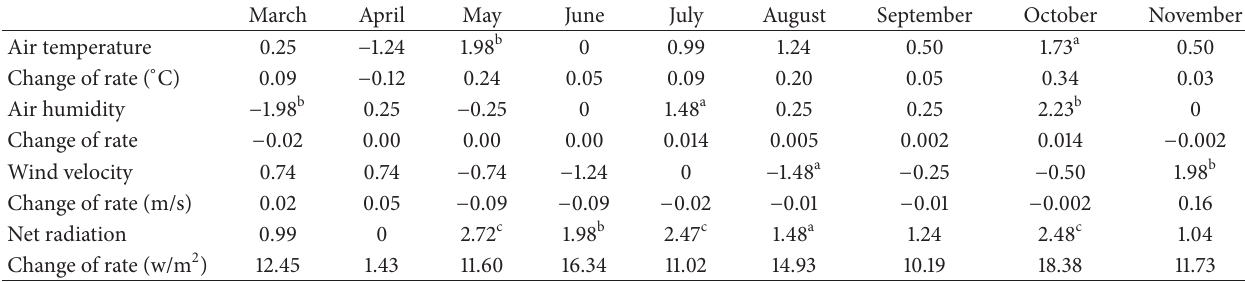
Table 8: 𝑍 values of M-K tests on rate of monthly evaporation change, air and lake temperature, air humidity, and wind